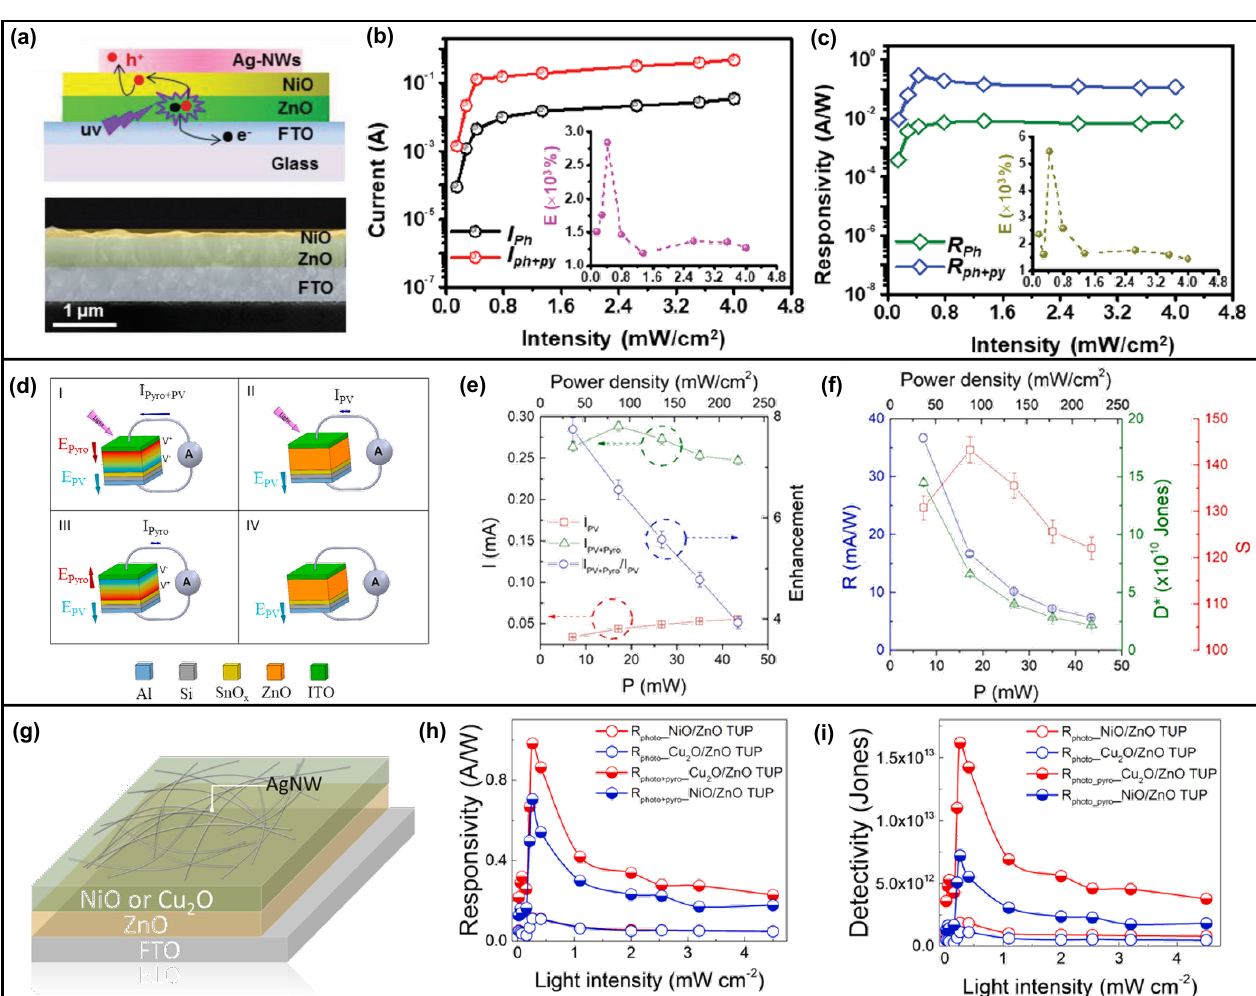
Figure 8. ( a ) Schematic illustration of the working mechanism of the self-powered photodetection based on p-NiO/n-ZnO heterojunction with the corresponding cross-sectional field-emission scan- ning electron microscopy image; ( b , c ) The short-circuit current response and the responsivity re- sponse showing the photovoltaic contribution combined with the pyroelectric current at different UV intensities. Reproduced with permission from [65]. Copyright 2019 Wiley; ( d ) Schematic repre- sentation of the pyro-phototronic effect in the Al/Si/SnO x /ZnO/ITO device for a complete chopper period; ( e , f ) Variation of I Pyro + PV , I PV , and I Pyro + PV /I PV and responsivity, detectivity, and sensitivity as a function of laser power density. Reproduced with permission from [69]. Copyright 2021 Elsevier; ( g ) Schematic of transparent ZnO-based photodetector; ( h , i ) The UV light (λ = 365 nm, 70 Hz) inten- sity dependence behavior of responsivity and detectivity for ZnO-based photodetector. Reproduced with permission from [70]. Copyright 2022 Elsevier.